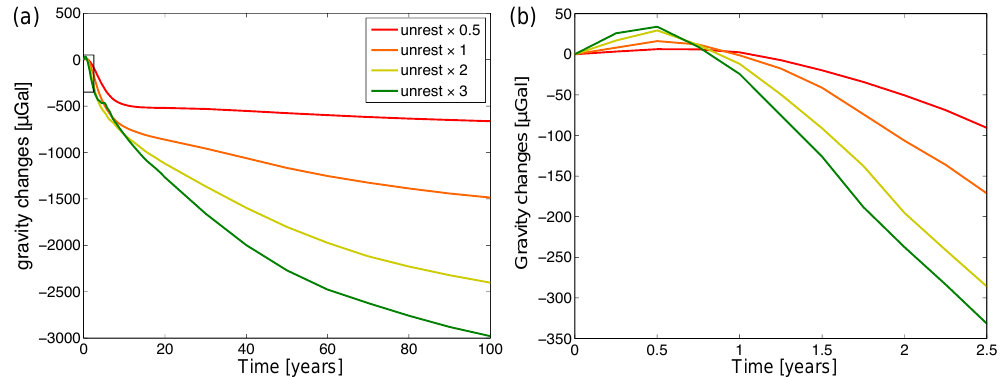
Figure 12. Computed (residual) gravity changes at the centre of the model (r = 0 ,z = 0 ) during 100 years on unrest (a) for Scenario I with different injection rates (see Table 4): unrest × 0 . 5, unrest × 1, unrest × 2, unrest × 3. (b) Close-up of the first 2.5 years of unrest (boxed on a ).